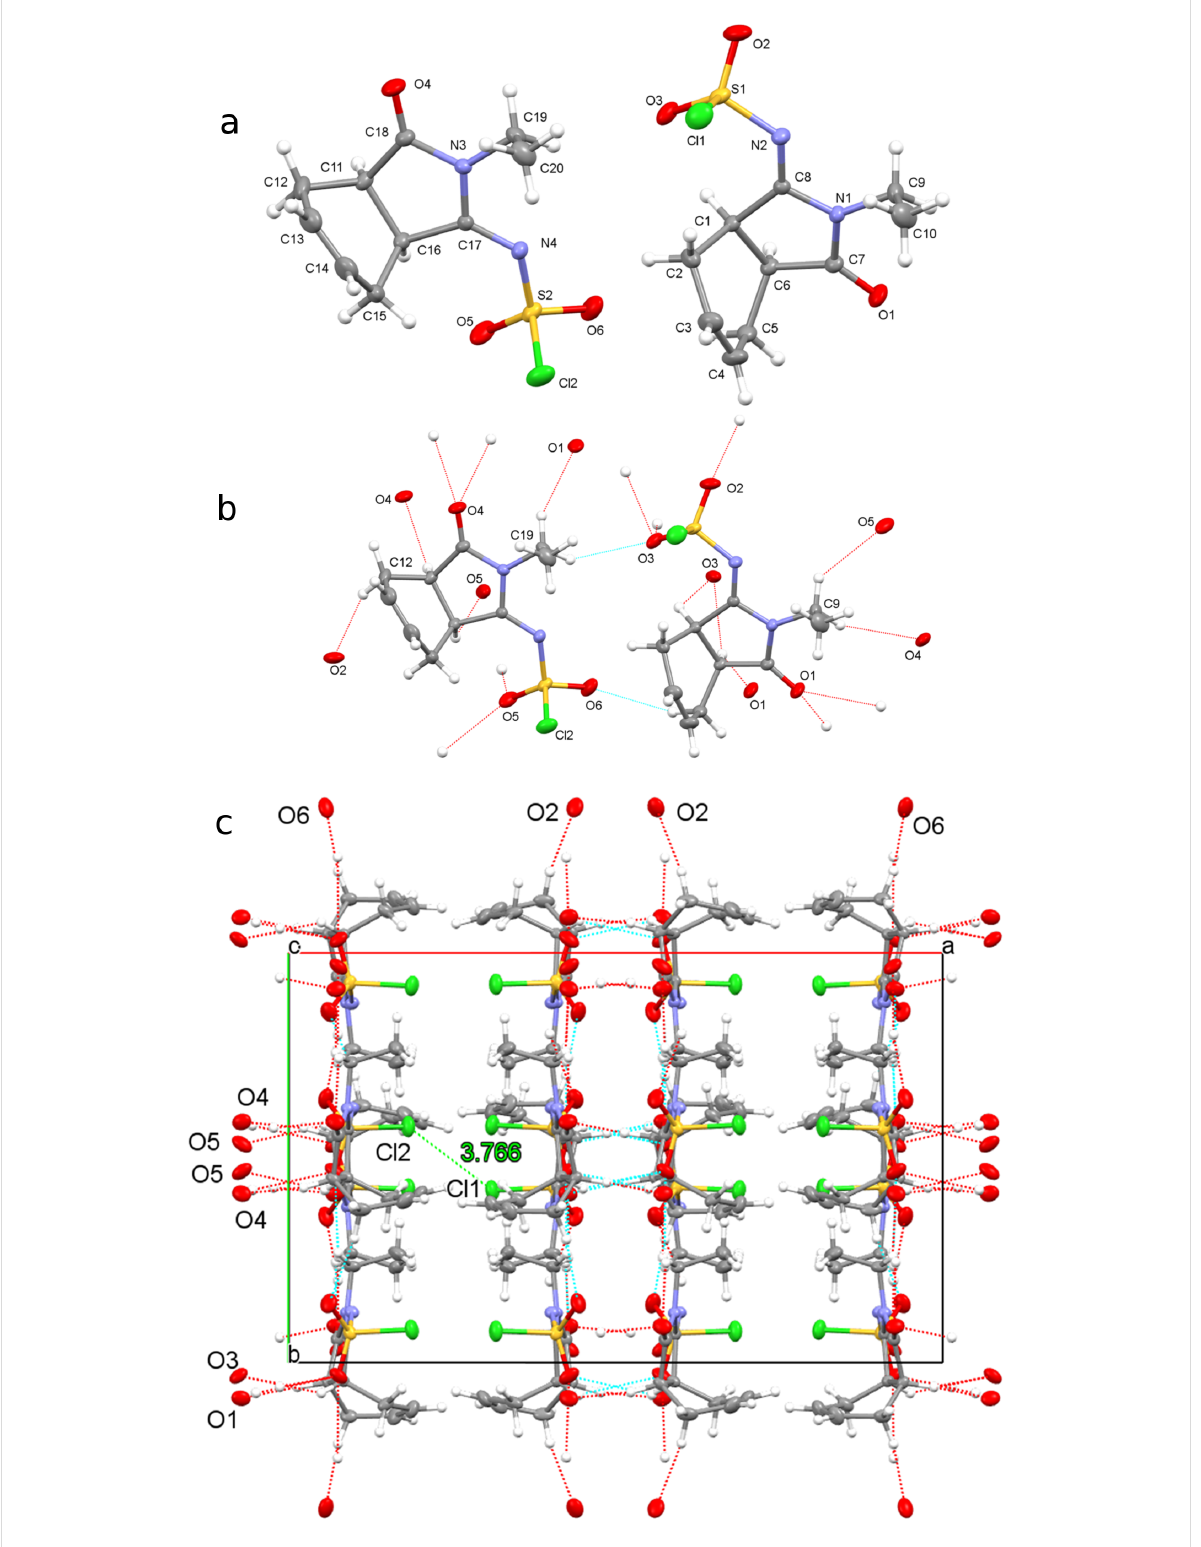
Figure 2: (a) Molecular structure of racemic molecule 10 (asymmetric unit). Thermal ellipsoids are drawn at the 30% probability level. (b) Geometric parameter with H-bonded geometry. Hydrogen bonds are drawn as dashed lines. (c) Stacking motif with the unit cell viewed downward along the c-axis. Dashed lines indicate C–H ∙∙∙ O